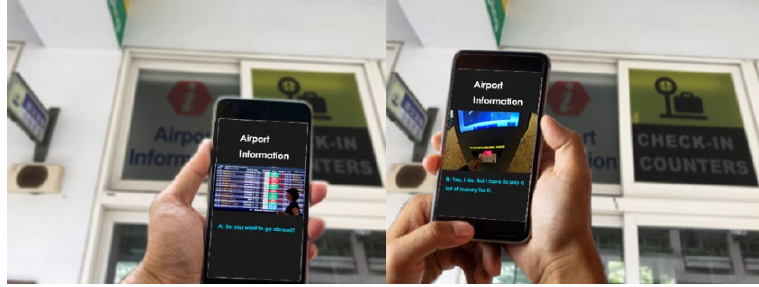
Figure 4. Experimental group students use the HP Reveal AR app to scan airport images and obtain airport situational videos for contextual learning.